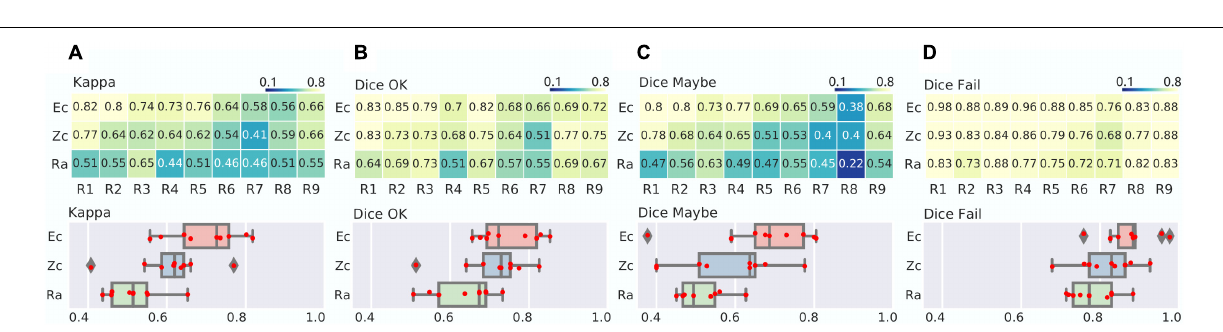
FIGURE 3 | Zooniverse, expert and radiologist agreements. (A) Matrix of Kappa agreement between consensus of experts (Ec), zooniverse users (Zc) and radiologist (Ra) raters, in rows, vs. individual experts (R1–R9), in column (top). The distribution of agreement is also presented (bottom). (B–D) Matrix and distribution for the Dice agreement in the OK (B) , Maybe (C) , and Fail (D)